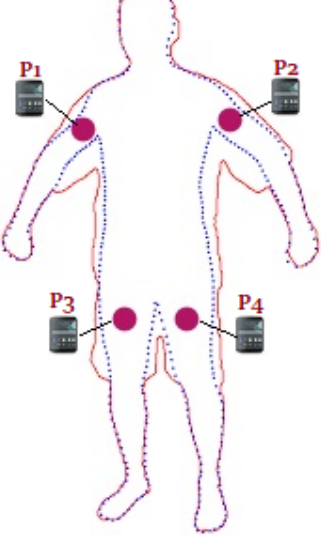
Figure 3. Mobile placements (P1, P2, P3, and P4) on the human body during the data collection.